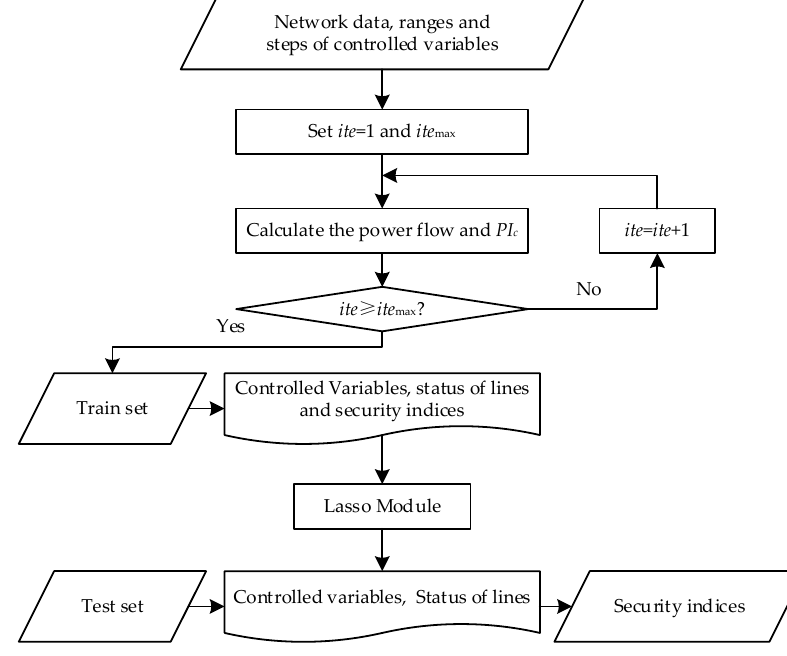
Figure 3. Solution process of the least absolute shrinkage and selection operator (Lasso) module.